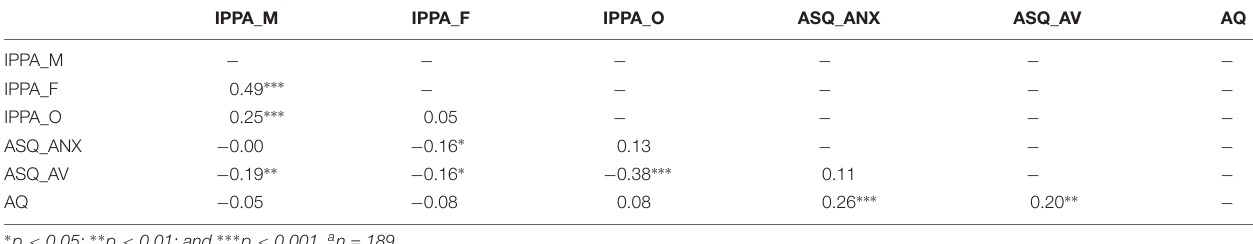
TABLE 2 | Correlations of the parent and peer attachment (IPPA), anxiety and avoidance dimensions of attachment style questionnaire (ASQ) and aggression questionnaire (AQ) for male a adolescents. IPPA_M